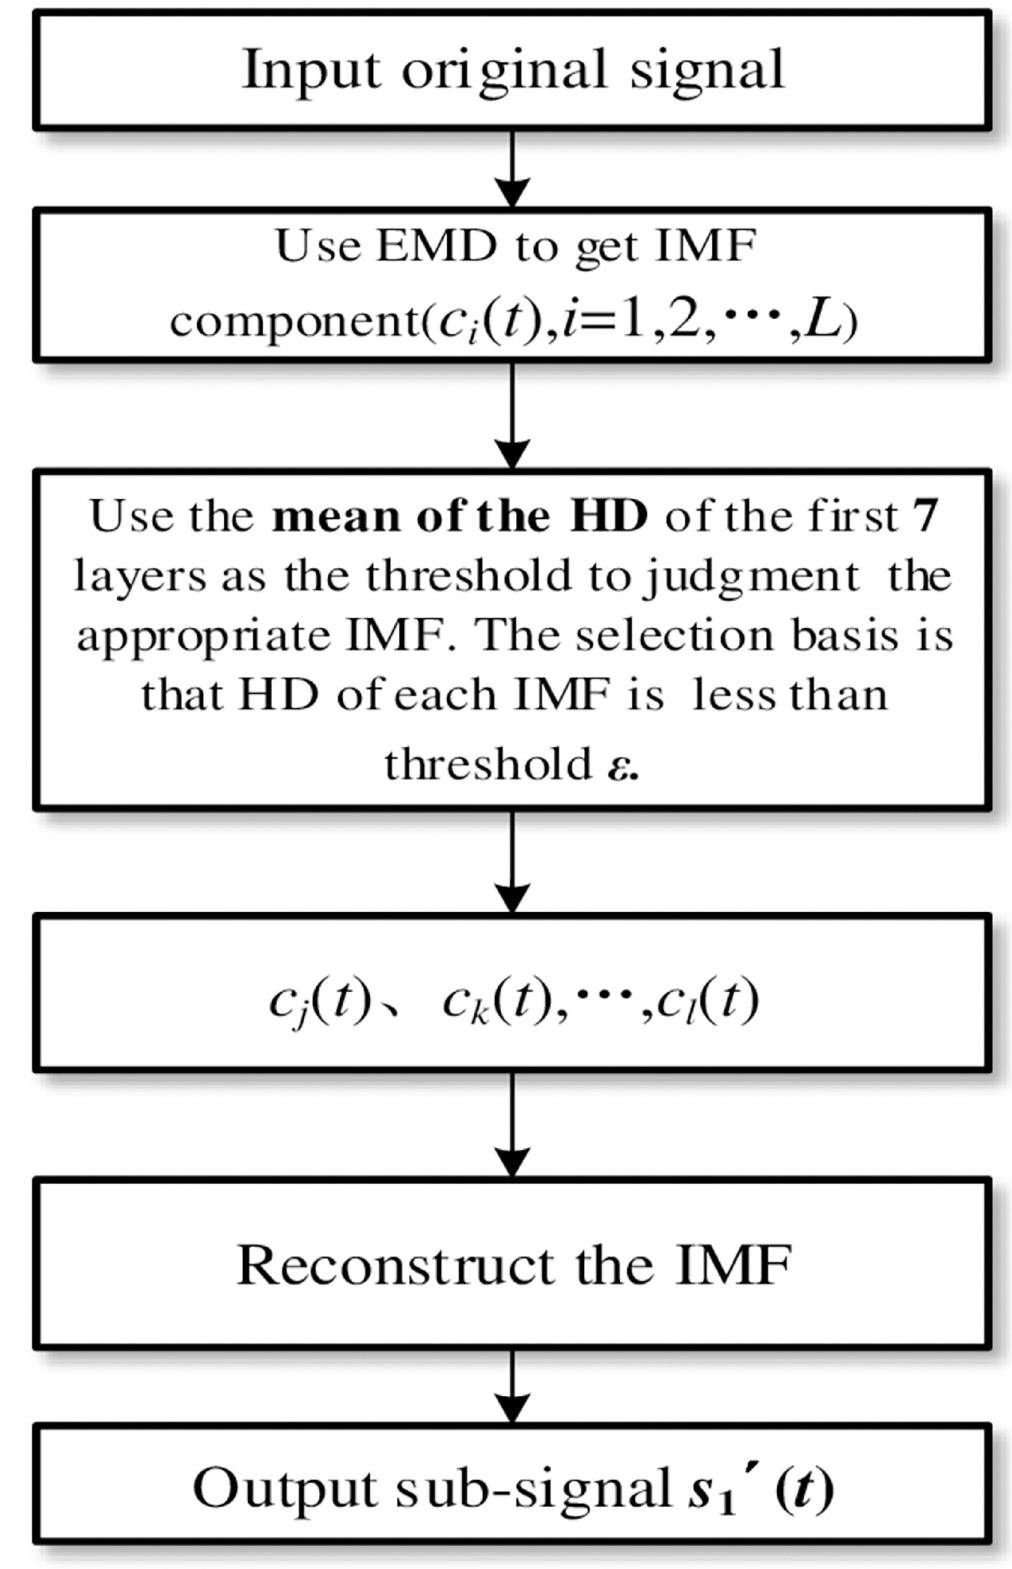
Fig 5. Heart sound flowchart based on EMD adaptive HD